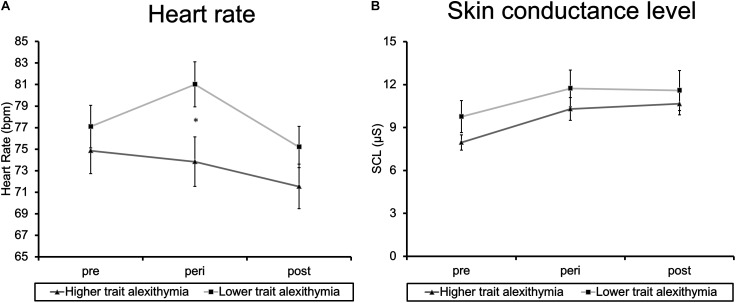
Group means of (A) heart rate and (B) skin conductance level at pre-, peri-, and post-film assessment. Error bars represent standard error of the mean, ∗indicates p < 0.05.